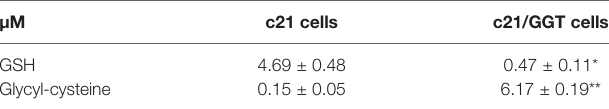
Low molecular weight thiols were assayed after 24 h cell culture in sulfur aminoacid-free (SAF)medium.Dataaremeans±SDofthreedetns.*p<0.01;**p<0.001.Modi fi ed,from Franzini et al.